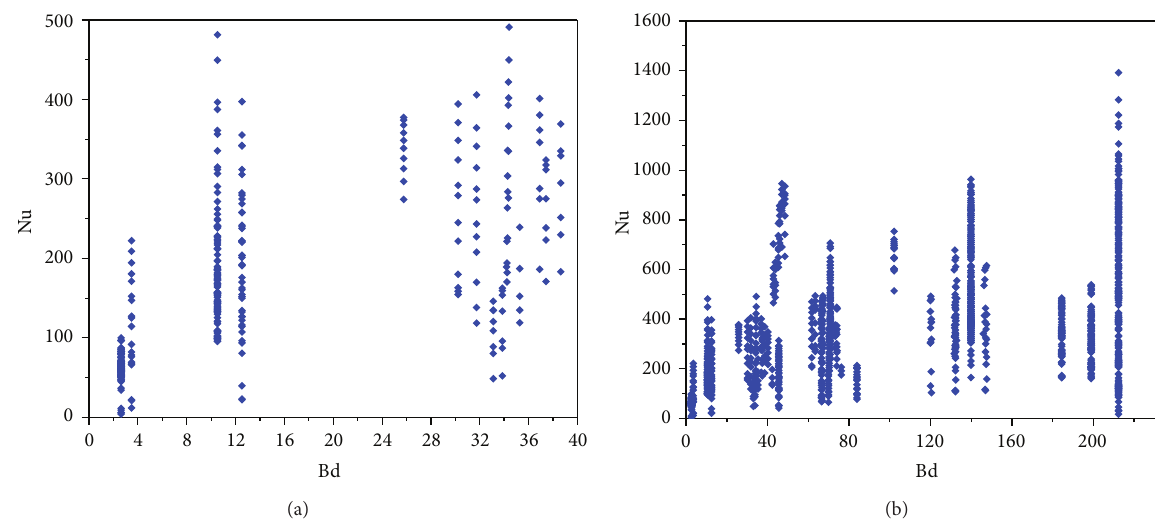
Figure 5: Statistics of the database with Bd and Nu as